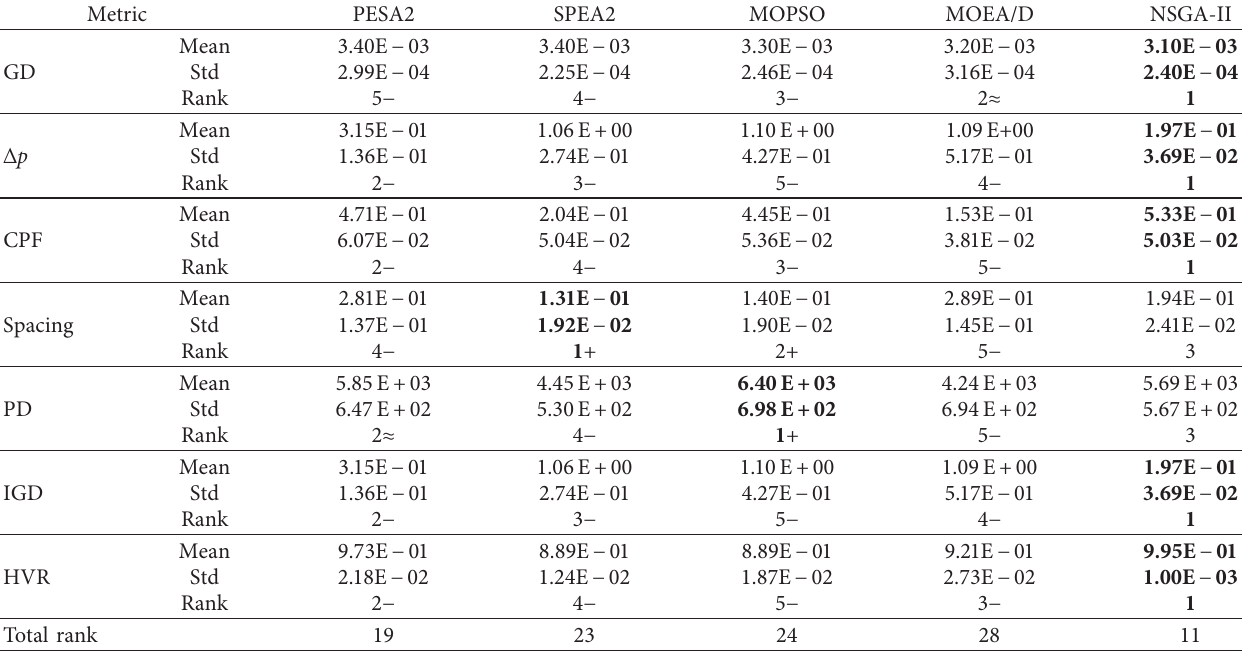
Table 3: Comparison results of performance metric.